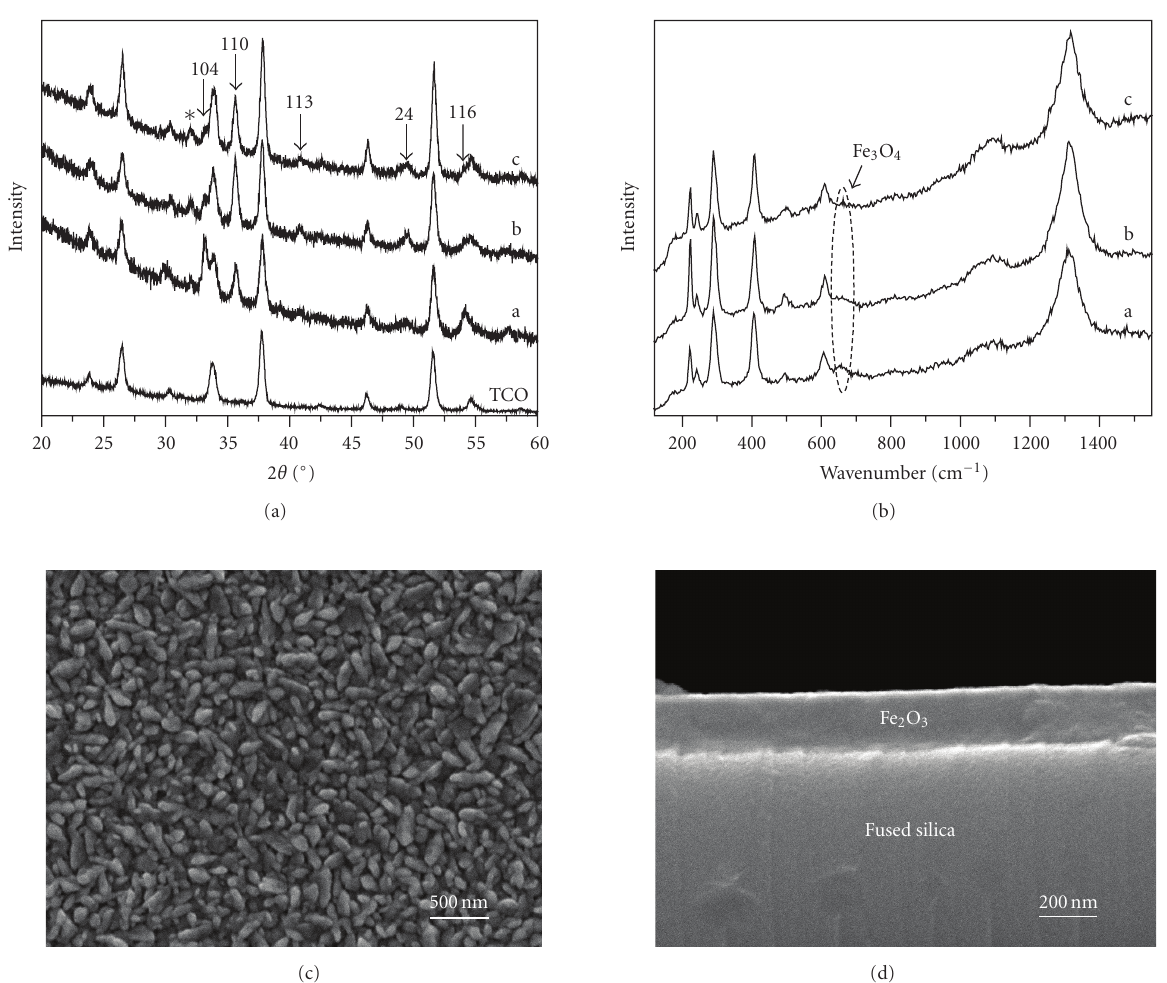
Figure 1: (a) XRD of Fe 2 O 3 films doped with 0.1% Si deposited at (a) 350 ◦ C, (b) 400 ◦ C, (c) 450 ◦ C. The di ff raction pattern of the TCO substrate fired at 400 ◦ C in the air is also shown for comparison. Undefined peaks are marked with ∗ . (b) Raman spectra of Fe 2 O 3 samples doped with 0.2% Si deposited at (a) 350 ◦ C, (b) 450 ◦ C, (c) 500 ◦ C. (c) SEM micrographs showing the typical morphology of the Fe 2 O 3 films on TCO. (d) Cross-section of a 200 nm Fe 2 O 3 film on a fused silica